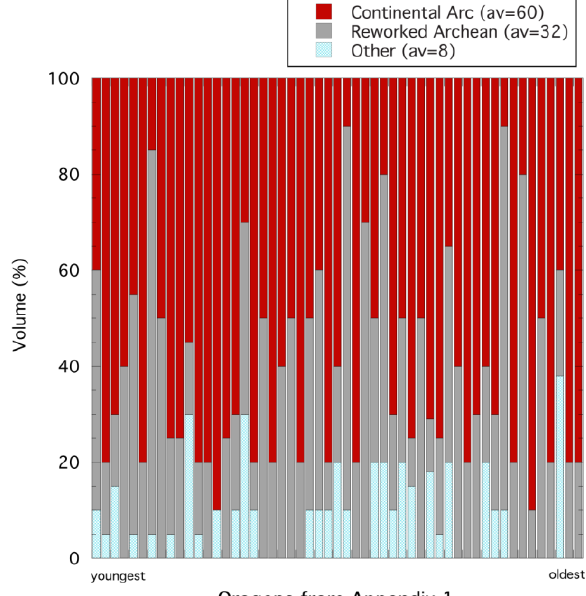
Figure 10. Volume percent of tectonic settings preserved in Proterozoic orogens (data from Appendix 1). Other: oceanic crust, serpentinites, pelagic sediments, oceanic islands and plateaus; av: average